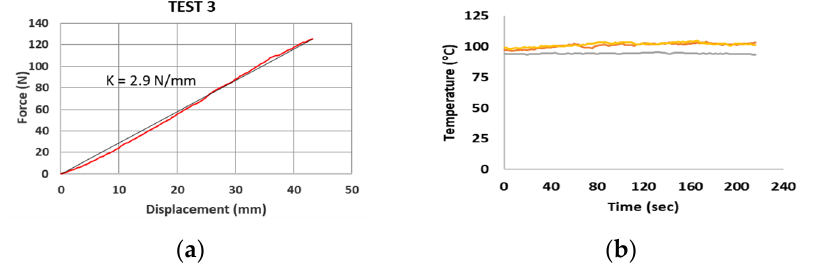
Figure 14. SMA (austenite) compression tests: ( a ) force–displacement; ( b ) temperature variation during time.